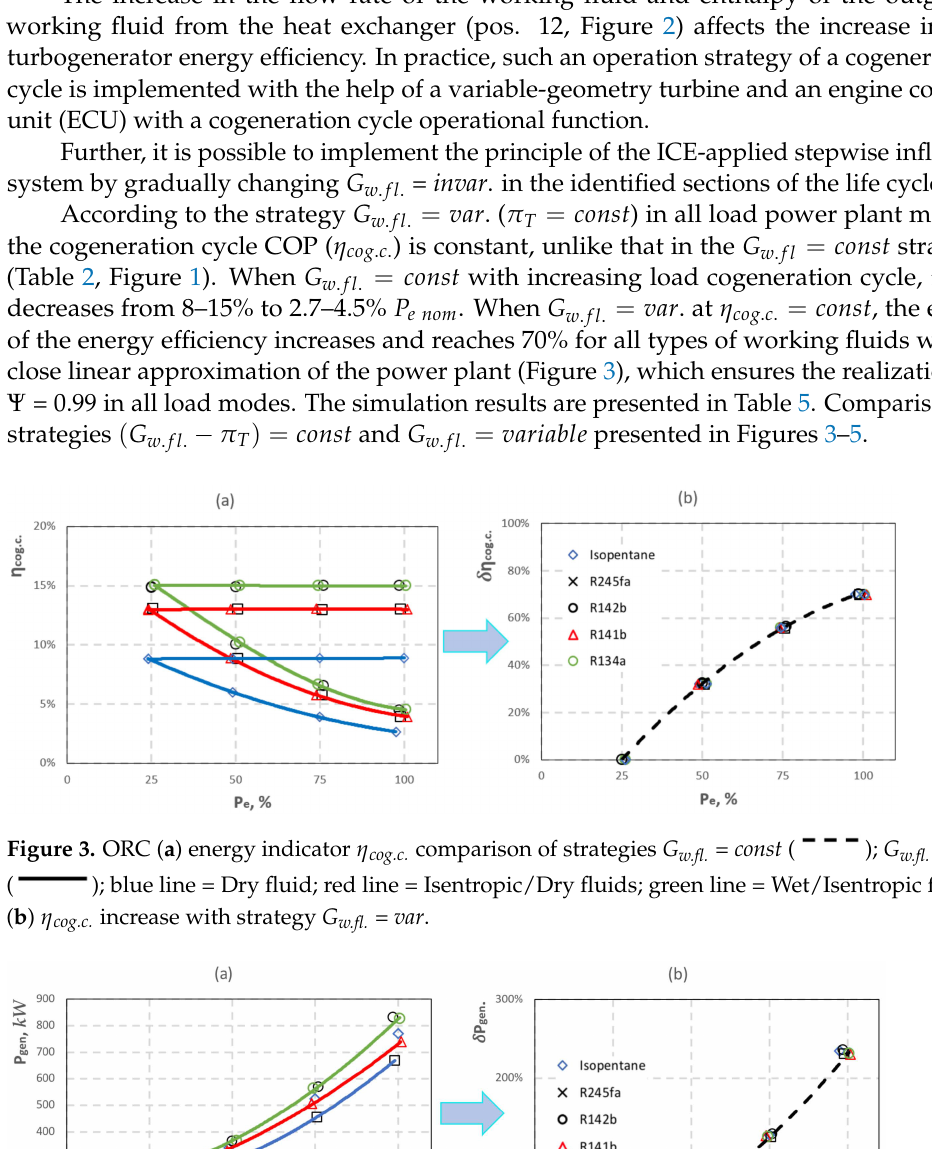
G w.fl. = var . ( ); blue line = Dry fluid; red line = Isentropic/Dry fluids; green line = Wet/Isentropic fluids; ( b ) P gen increase with cogeneration cycle with strategy